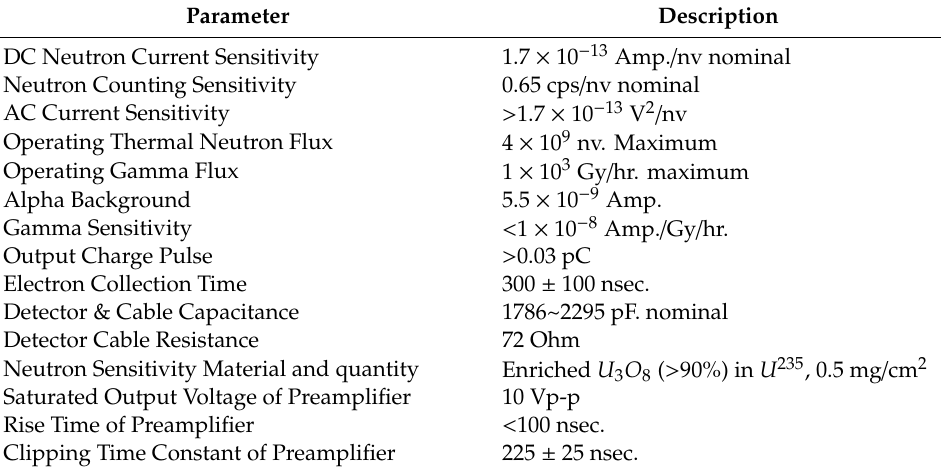
Table 1. Data of the selected fission chamber and the preamplifier